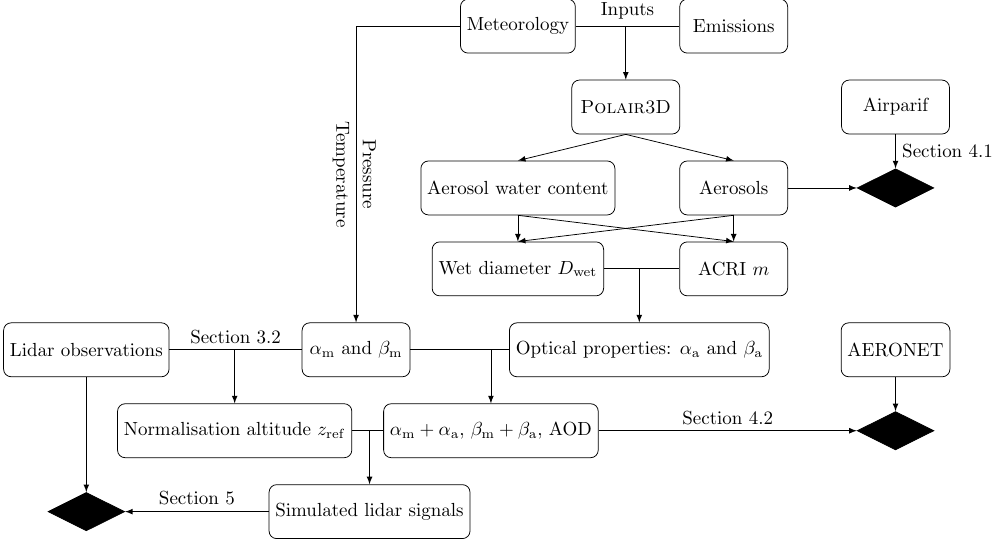
Fig. 2. Diagram describing the methodology for lidar signals modelling from outputs of the air quality model P OLAIR 3D. Comparisons to measurements are performed at black nodes. ACRI stands for aerosol complex refractive index. β m ( β a ) is the molecular (aerosol) backscatter coefficient. α m ( α a ) is the molecular (aerosol) extinction